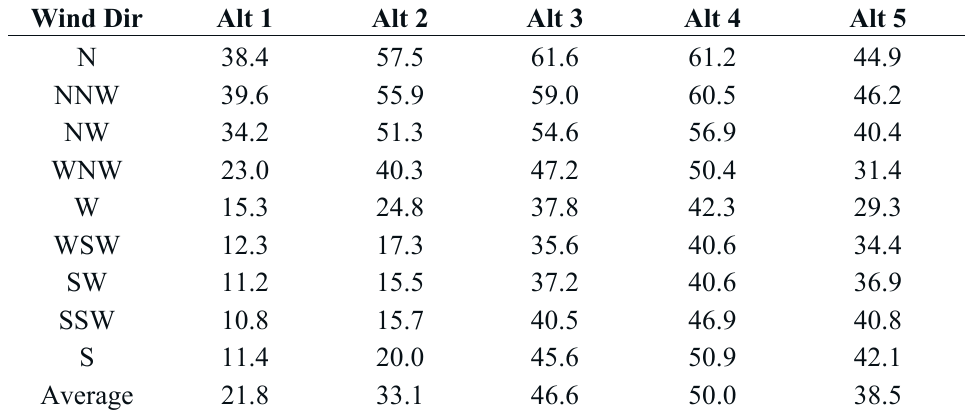
Table 4. Average of wave height reduction factors along north shoreline (Sta 5 to 25) at WL = 0 m.